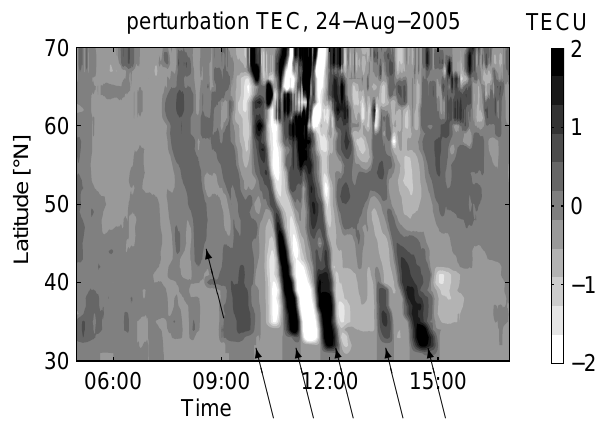
Fig. 6. Thick solid line: electron density profile 29 October 2003 14:52–14:58UT, 335 ◦ E/44 ◦ N (13h local time). Thin solid line: electron density profile 27 October 2003 15:09–15:13UT, 334 ◦ E/45 ◦ N. Dotted line: Mean profile of all measured profiles between 29 September–27 October 2003, 40 and 60 ◦ N, 315 and 355 ◦ E. The electron density profiles are derived from ionospheric radio occultation measurements onboard CHAMP.